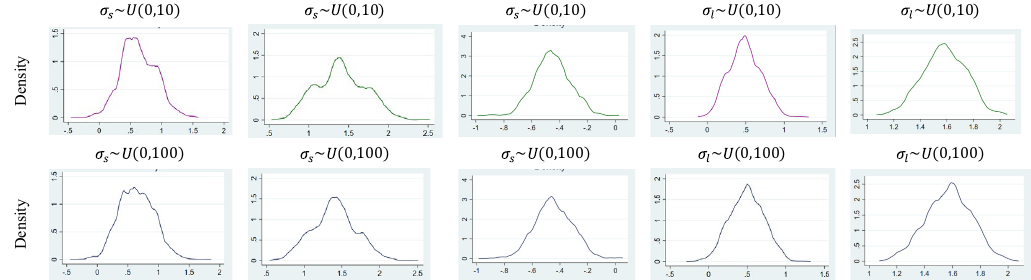
Figure 2 Sensitivity analysis of variance ( s s and s l are for safety and